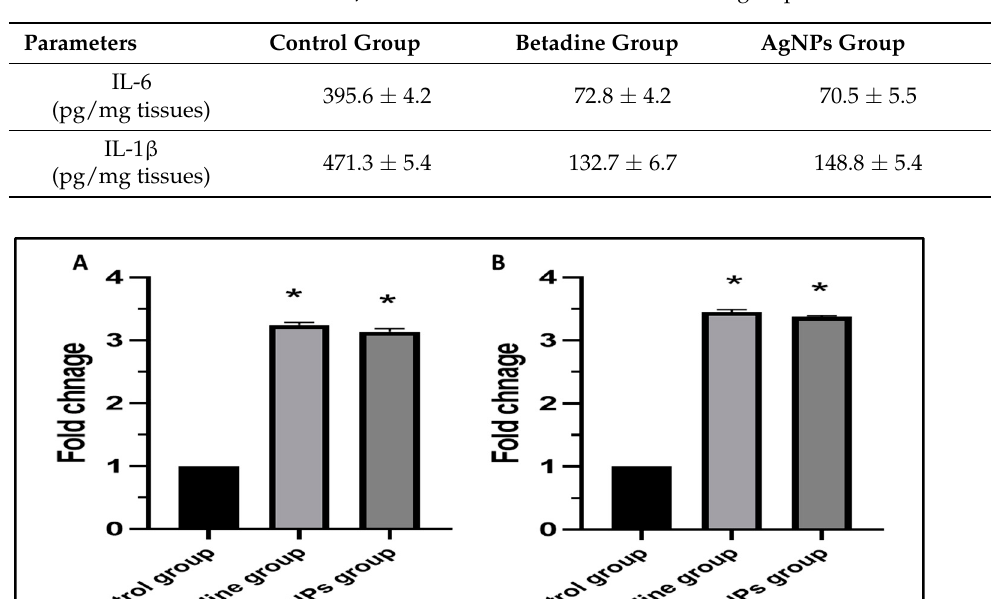
Figure 15. TNF- α immunohistochemical staining of ( A ) section in normal skin (negative control) showing negative TNF- α immunostaining ( − ) as no wound healing area (×100). ( B ) Section in the wound of the control group showing strong positive immunostaining (+++) in the wound healing area (×100). ( C ) Section in the Betadine™-treated group showing mild positive TNF- α immunostaining (+) in the wound healing area (×100). ( D ) Section in the AgNPs-treated group showing negative TNF- α immunostaining ( − ) in the wound healing area (×100). Table 3. The levels of IL-6 and IL-1 β of the wound tissues of the different groups.